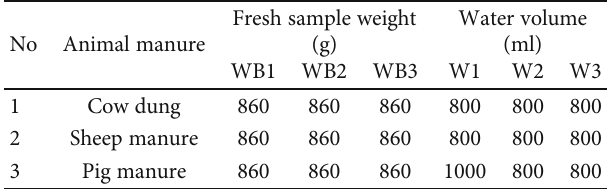
Table 1: Preparation of digester for biogas production.